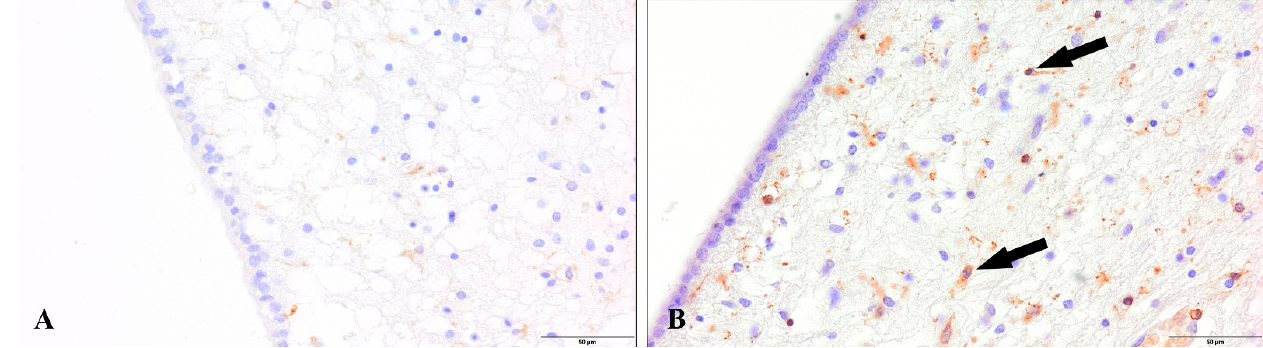
Figure 8. Subventricular zone. ( A ). Control group. ( B ). Active ramified microglia (arrows). Group patients with diagnosed COVID-19. Immunolabeling LCA antibody.